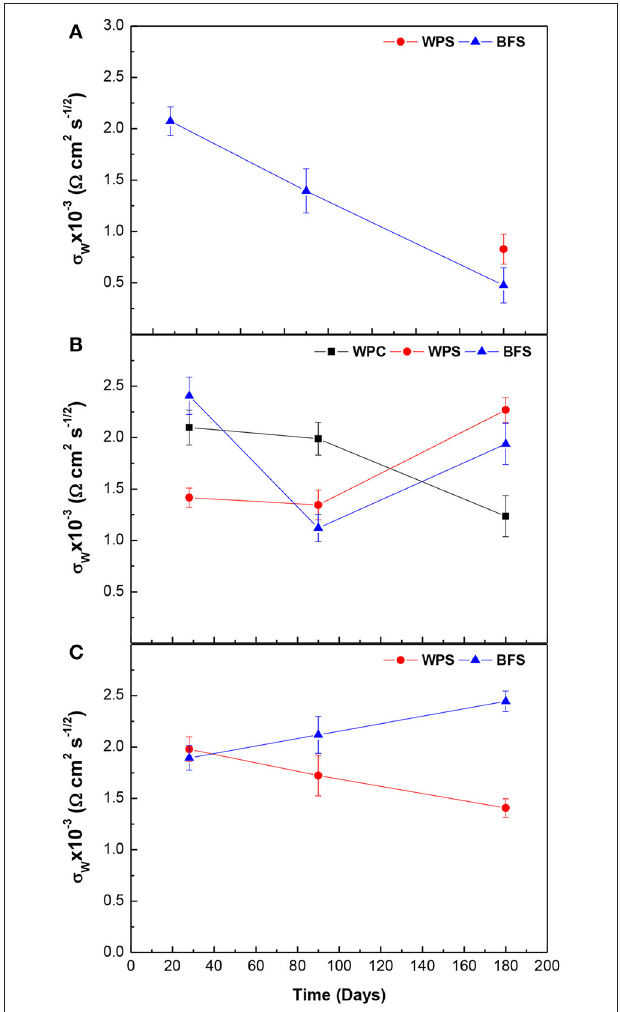
FIGURE 11 | Comparison of Warburg coefficient σ w , for the three types of specimen under different environments: (A) alkaline solution, (B) alkaline chloride-rich solution, and (C)